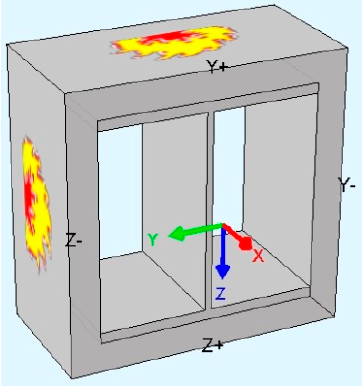
Figure 4. Visual appearance of the structure simulated in SOFiSTiK.